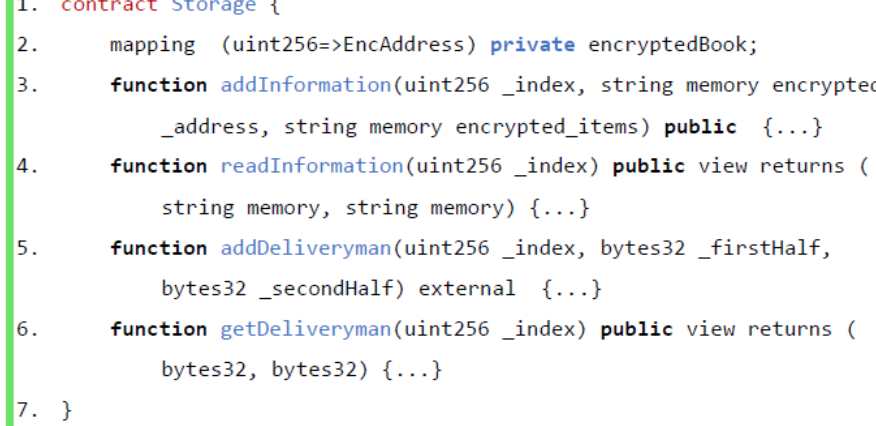
Figure 14. Data manipulation control function implementation.